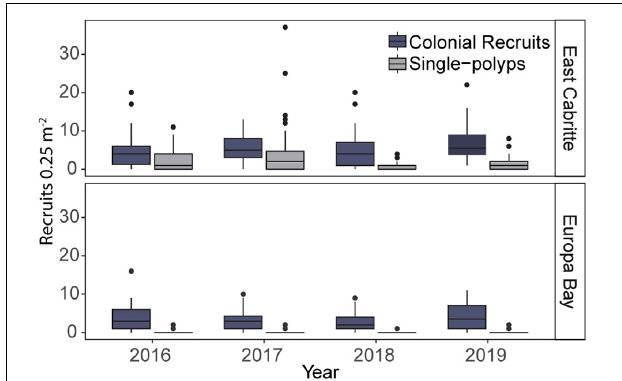
FIGURE 4 | Boxplot comparing the median, 25th and 75th percentiles of single-polyp and colonial recruit abundances on reef substrata from 2016 to 2019. Abundances of single-polyps and colonial recruits were consistently higher at East Cabritte than at Europa Bay ( p < 0.001). The abundance of single-polyps and colonial recruits declined in 2018 ( p < 0.001), but at East Cabritte, colonial recruit abundances increased in 2019 ( p < 0.05).